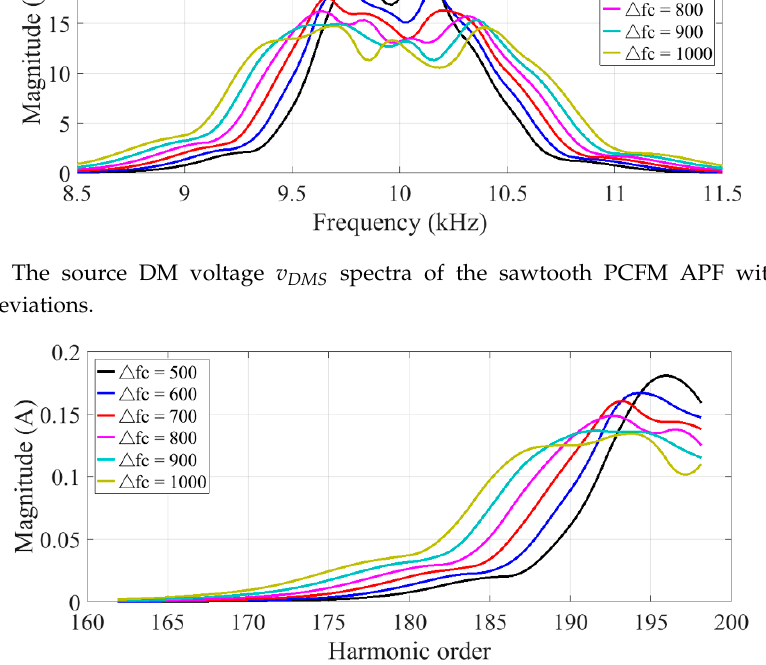
Figure 11. The low-frequency characterizations of the sawtooth PCFM APF with di ff erent frequency deviations.